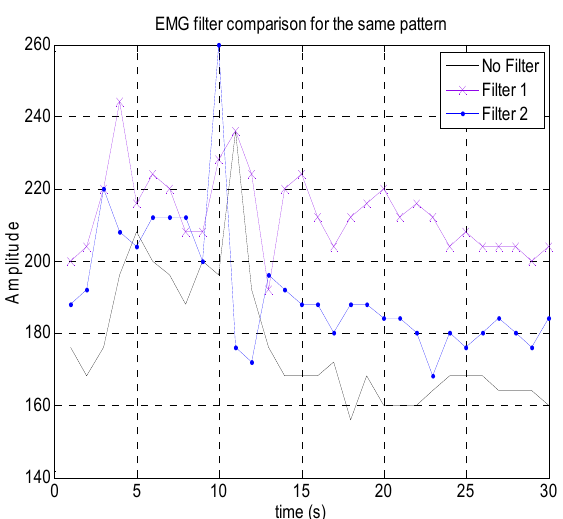
Figure 16. EMG measurement with the same muscle contraction pattern as in Figure 15. A sampling period of 1 s is used with various filtering options.